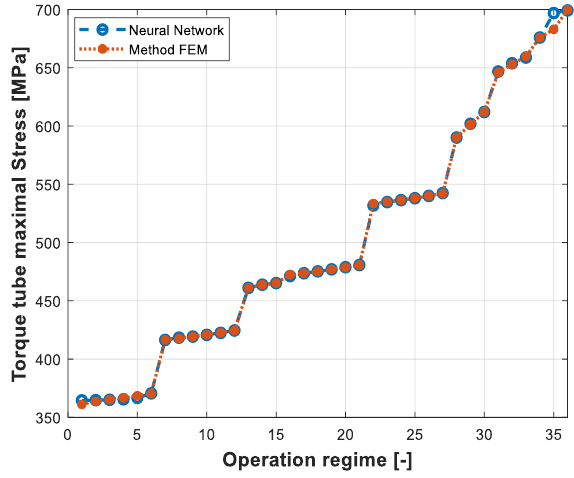
Figure 11. Predicted results of the torque-tube stress calculated by the NN and FEM.